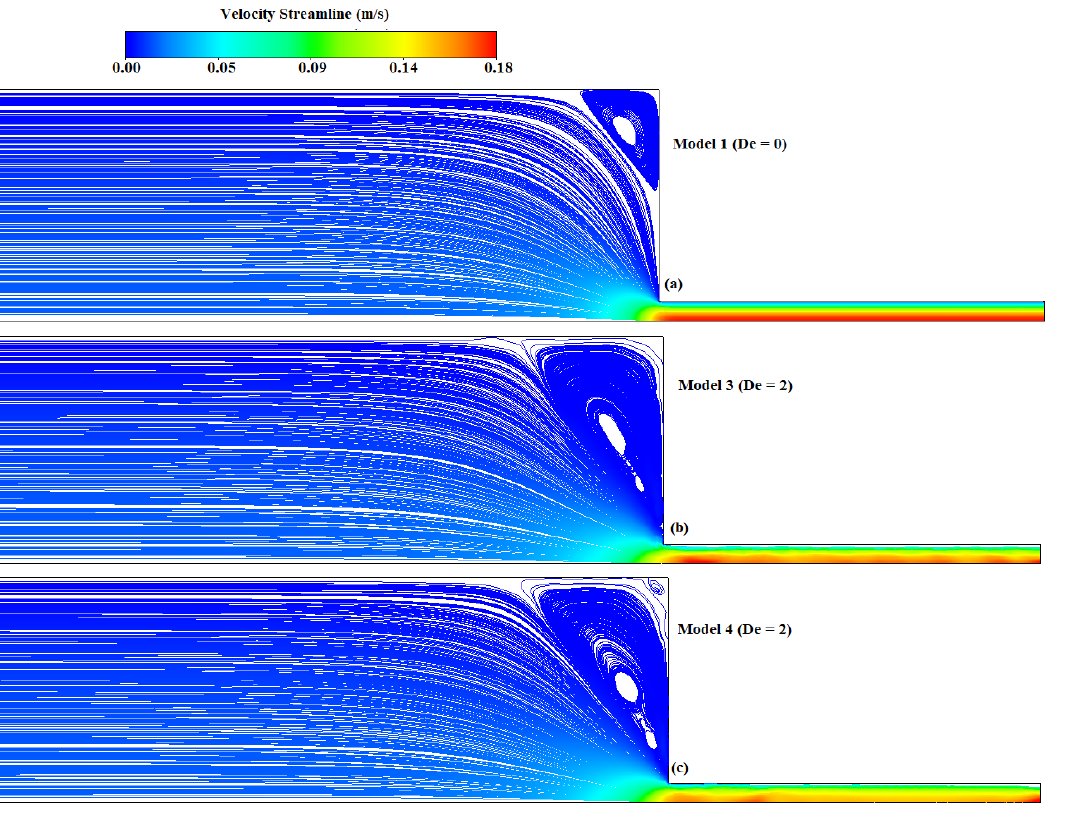
Figure 6. Flow patterns with ( a ) model 1, ( b ) model 3, and ( c ) model 4 in the axisymmetric contraction.